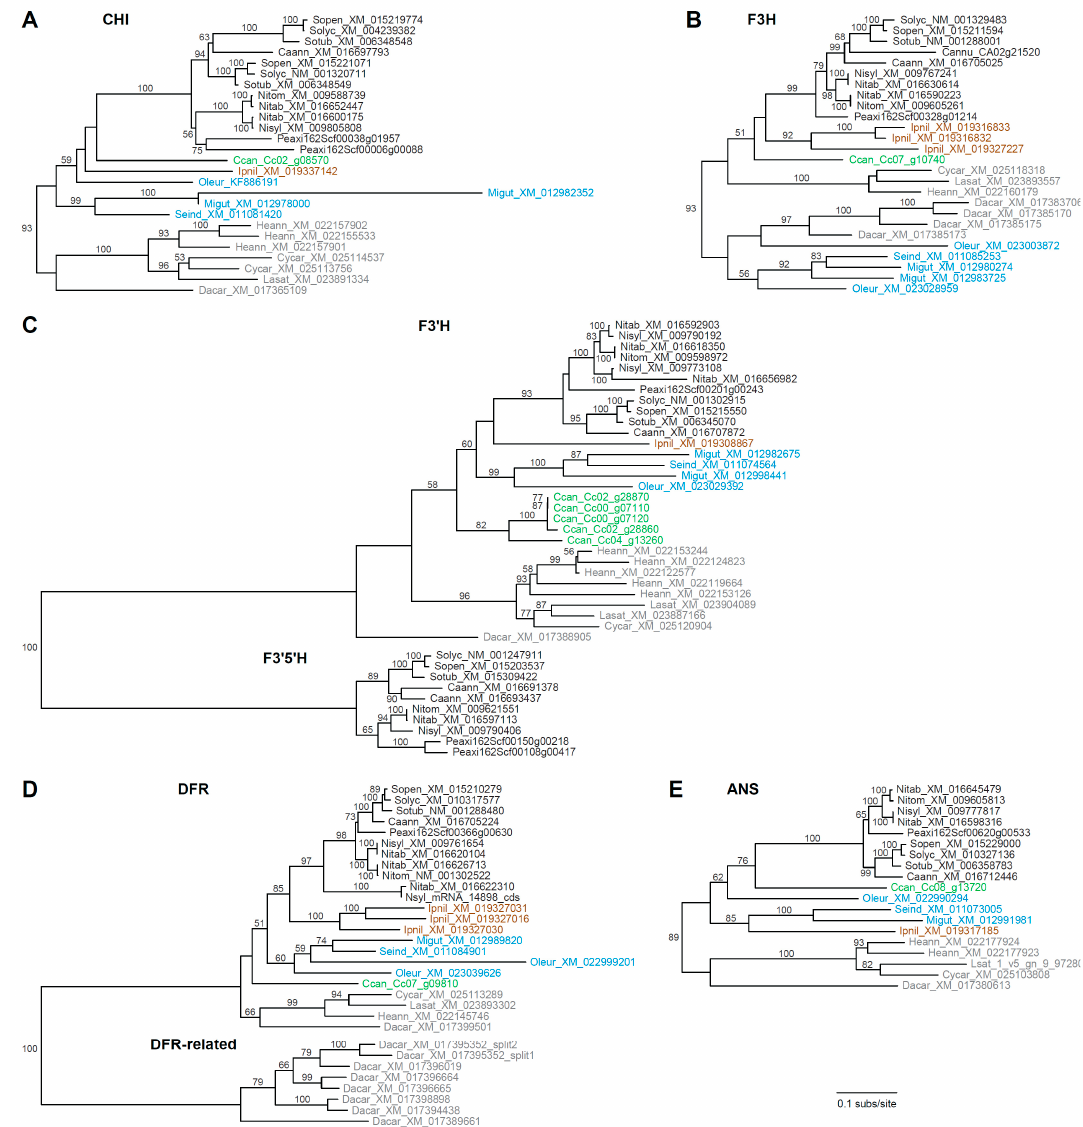
Figure 3. Phylograms depicting phylogenetic relationships among anthocyanin biosynthesis genes.